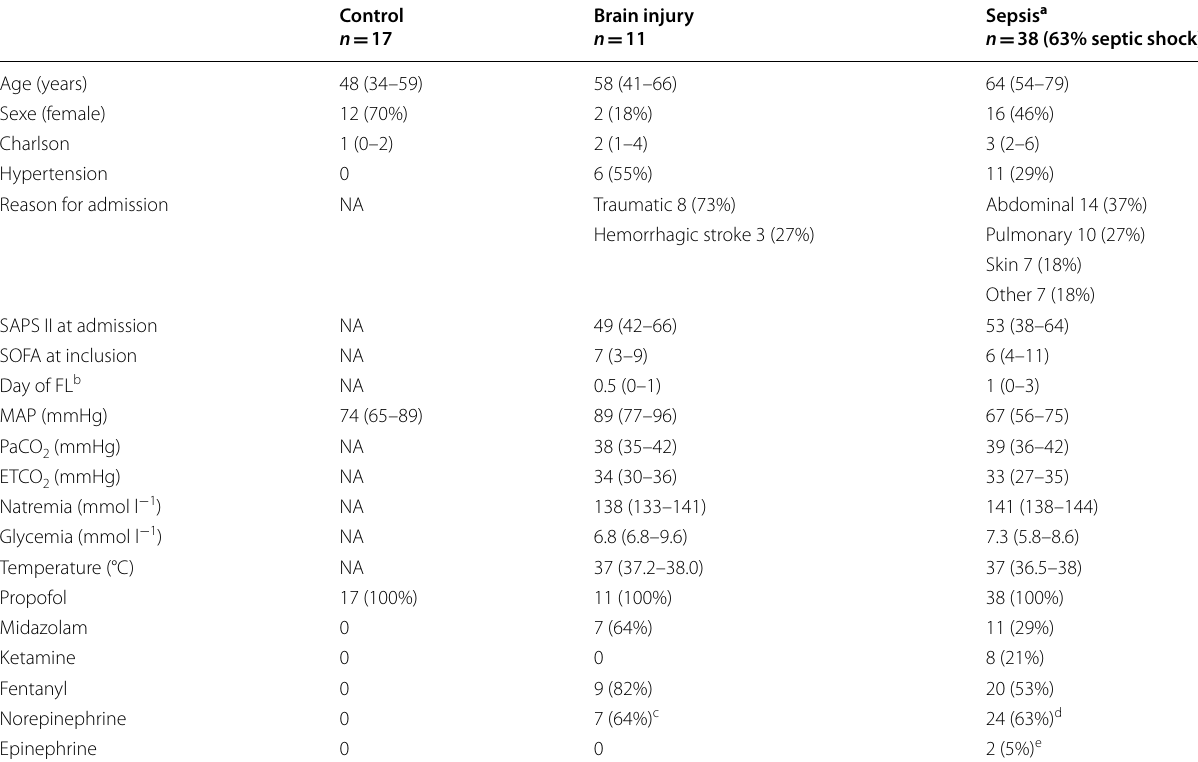
Table 1 Demographic